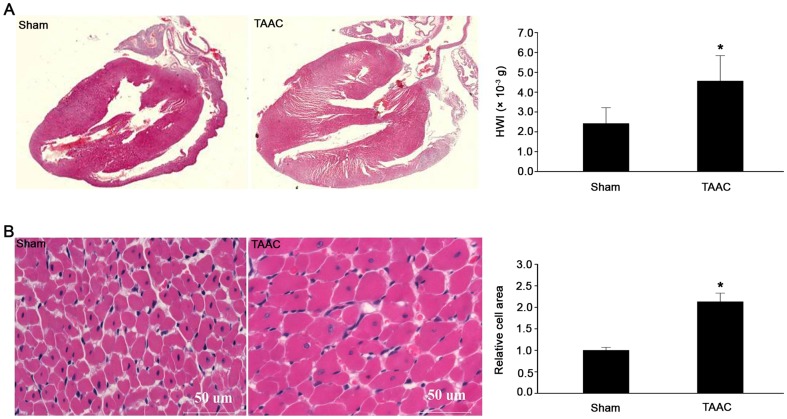
A rat model of cardiac hypertrophy assessed by histopathology.(A) Representative images of rat transthoracic echocardiography in Sham operation and transverse abdominal constriction (TAAC) after 4 weeks of animal experiments. H&E staining of heart tissue sections from Sham operation and transverse abdominal constriction (TAAC) after 4 weeks of animal experiments and images were acquired by scanning. The graph shows the heart and body weight and the heart weight index (HWI), which was calculated by heart weight to body weight ratio. *P<0.05 compared to the Sham rats. (B) H&E staining of heart tissue sections from Sham and TAAC rats and images were taken with scanning, the scar bar: 50 µm. Regions of myocardial hypertrophy were lighter in color with homogeneous staining, and showed numerous nuclear-free regions, with an increased nucleolar density in regions of muscle fiber atrophy. The graph summarizes data on relative cell area that were determined from local cardiac HE-stained paraffin sections and presented as mean ± SEM. *P<0.05 compared to the Sham rats.